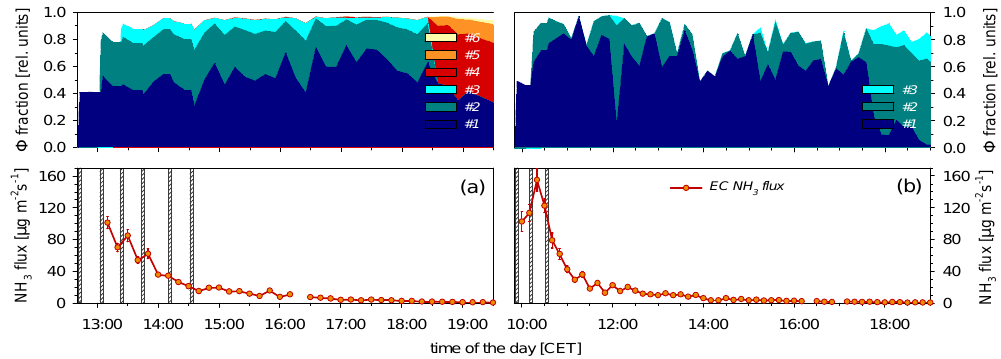
Fig. 4. Influence of the slurry tracks on the EC flux on (a) 4 August 2009 and (b) 6 August 2009 (6 and 3 tracks, respectively); upper panels: relative footprint ( 8 ) contributions of the individual slurry tracks to the EC flux measurement, white area displays the fraction of the flux footprint covering areas outside the fertilised tracks; lower panels: measured EC NH 3 flux, striped bars represent the actual time of the distribution of each track.